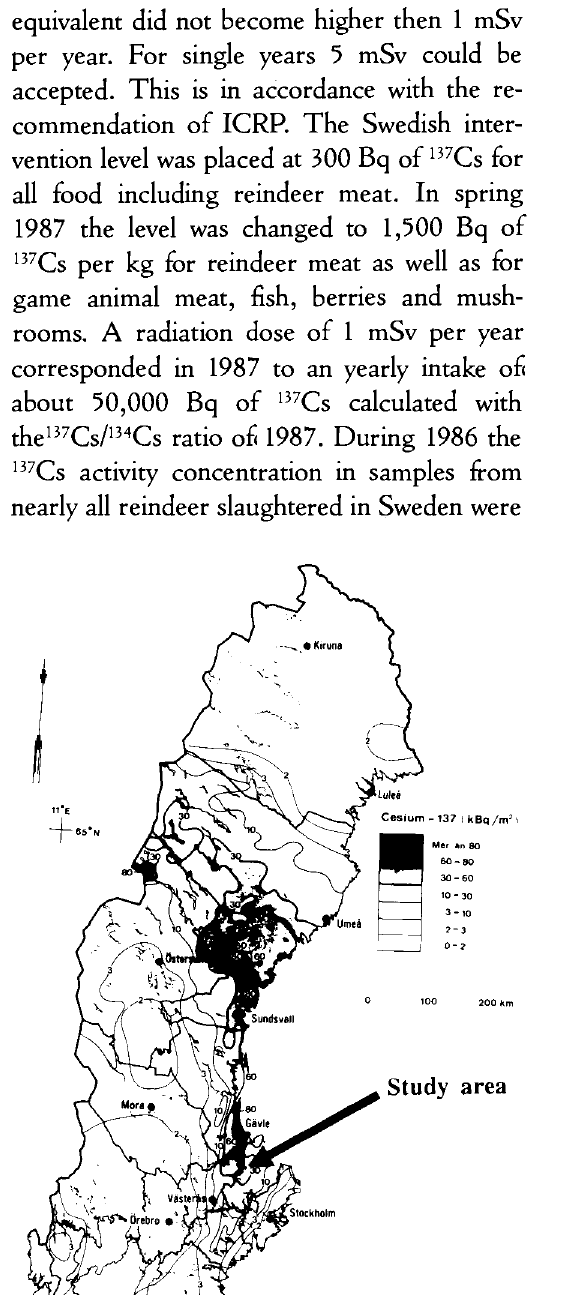
Fig. 1. The deposition of 137 Cs (kBq per m 2 ) in Sweden. Measurement performed by the Swedish Geological